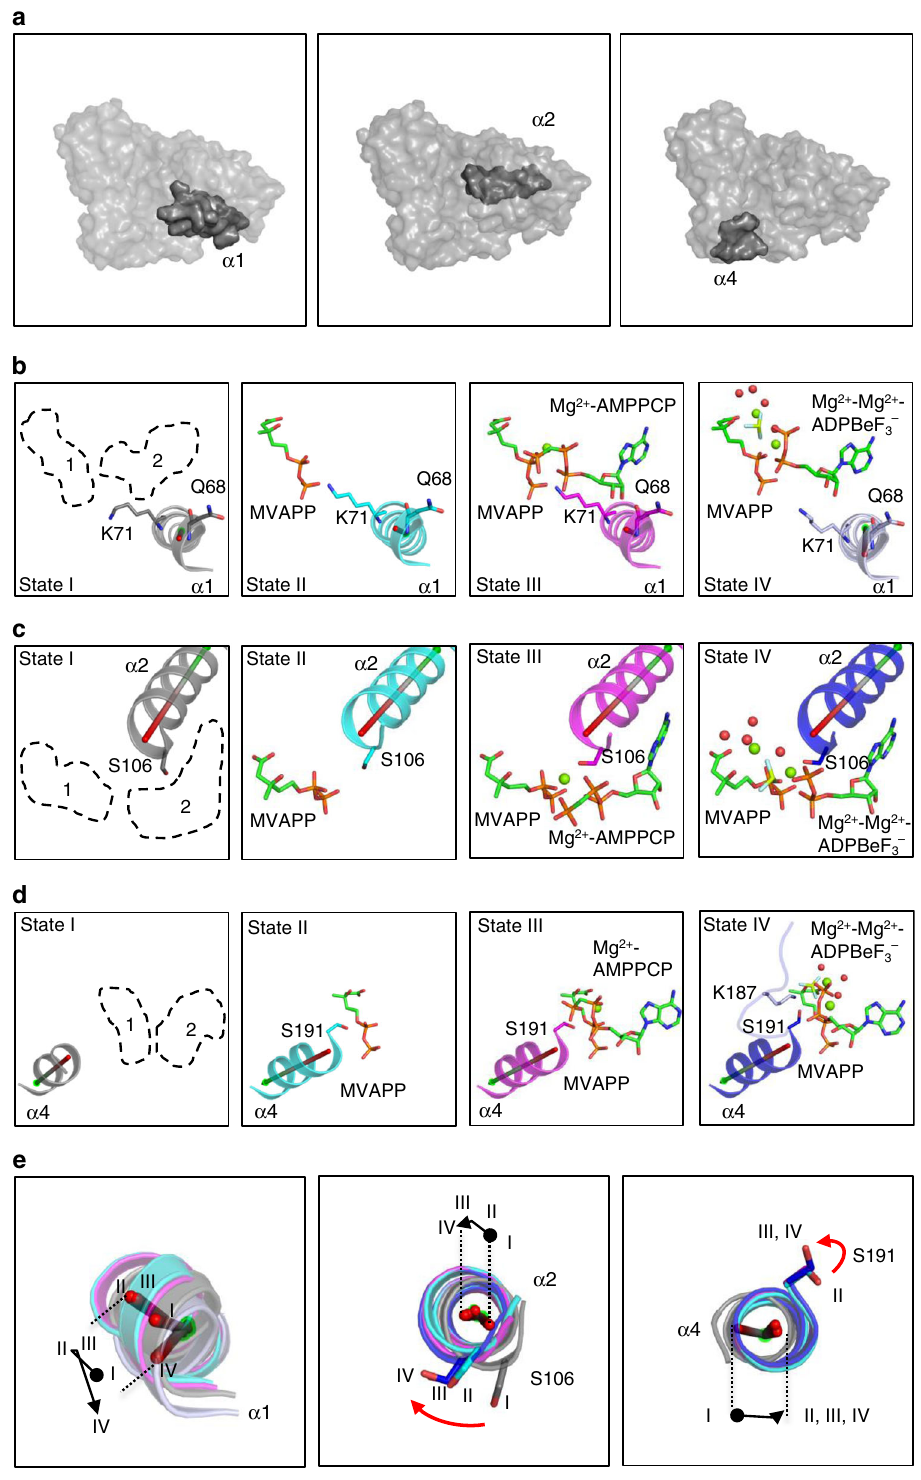
Fig. 5 Movements of helix α 1, α 2, and α 4 in the unbound and ligand-bound MDD EF . a Locations of helix α 1 (left), α 2 (middle), and α 4 (right) in MDD EF . b Positions of helix α 1 and key residues (Q68 and K71) in four different structures (left: apo-MDD EF , gray, state I; middle-left: MDD EF -MVAPP, cyan, state II; middle-right: MDD EF -MVAPP-AMPPCP-Mg 2 + , magenta, state III; right: MDD EF -MVAPP-ADPBeF 3 -Mg 2 + , blue, state IV). The binding sites of MVAPP (1) and ATP (2) are circled with dashed lines. The center of helix α 1 is shown as a rod colored in red (N terminus) and green (C terminus). Magnesium ions and water molecules are shown as green and red spheres, respectively. c Position of helix α 2 and key residues (S106) in four different structures as described in b . d Position of helix α 4 and key residues (S191) in four different structures as described in b . K187 in the β 10- α 4 loop (right panel) is shown as a stick model. e Superposition of helix α 1 (left), α 2 (middle), and α 4 (right) from four different structures. The helical movements of α 1, α 2, and α 4 upon substrate binding are drawn in black lines. The key residues, S106 and S191, in the middle and right panels are shown in stick and the side-chain movements are drawn in red